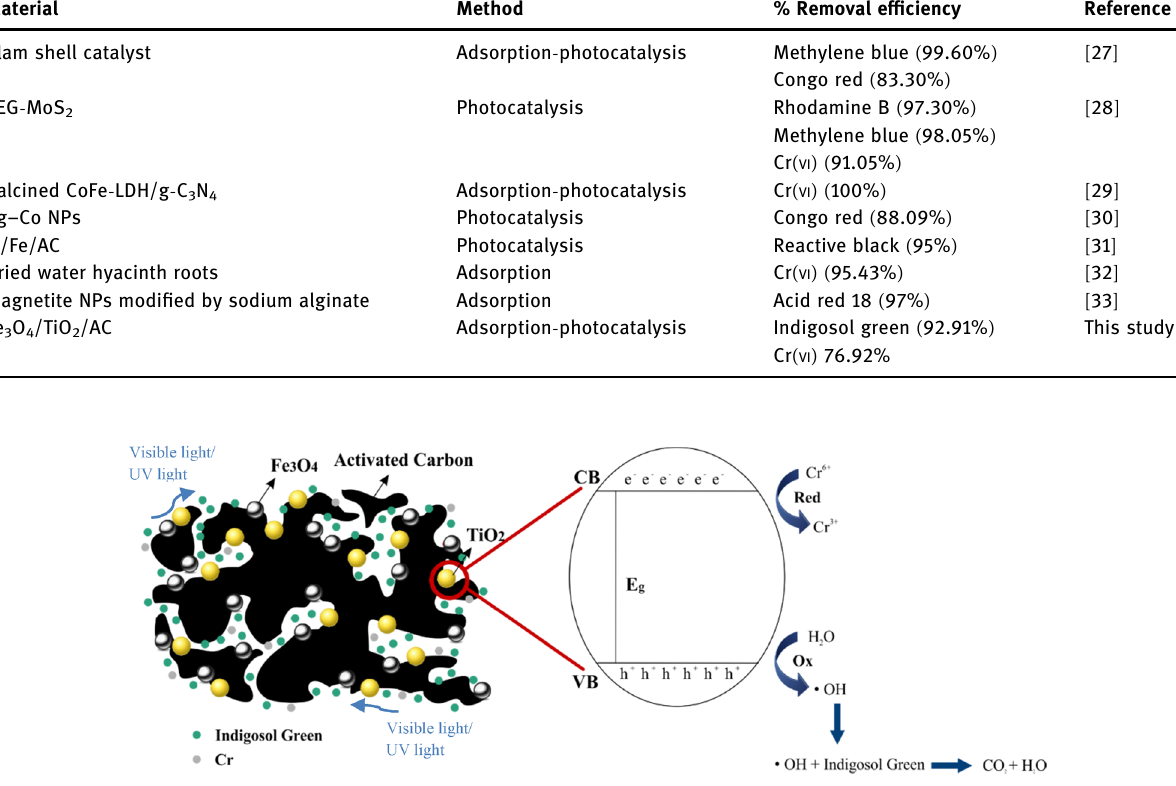
Figure 10: Schematic illustration for the removal of indigosol green and Cr ( VI ) over Fe 3 O 4 /TiO 2 /AC